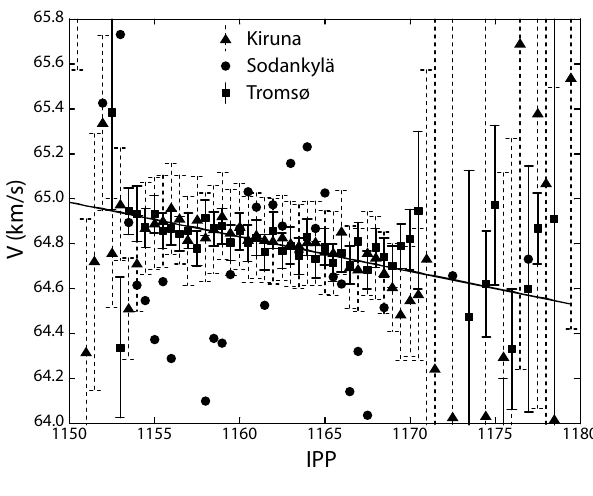
Fig. 4. The 194 meteoroid trajectories observed at autumnal equi- nox projected onto a plane perpendicular to the Tromsø beam. The Fig. 5. Velocity estimates from each receiver divided by the cosine Fig. 5. Velocity estimates from each receiver divided by the co- maximum SNR of each head echo streak is normalized to one. The of the angle to the derived meteoroid trajectory. Estimated uncer- sine of the angle to the derived meteoroid trajectory. Estimated un- white circle marks the –3 dB beamwidth ( 0 . 6 ◦ ). certainties for Kiruna and Tromsø are shown as vertical bars. The tainties for Kiruna and Tromsø are shown as vertical bars. The So- Sodankyl¨a uncertainties are ± 3 km/s and are not plotted as they dankyl¨a uncertainties are ± 3km/s and are not plotted as they exceed exceed the displayed velocity range. the displayed velocity